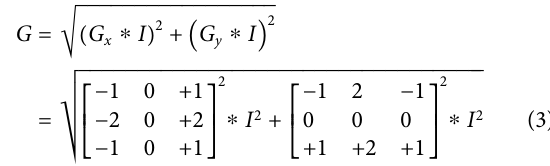
algorithm required multiple mathematical model conversions,